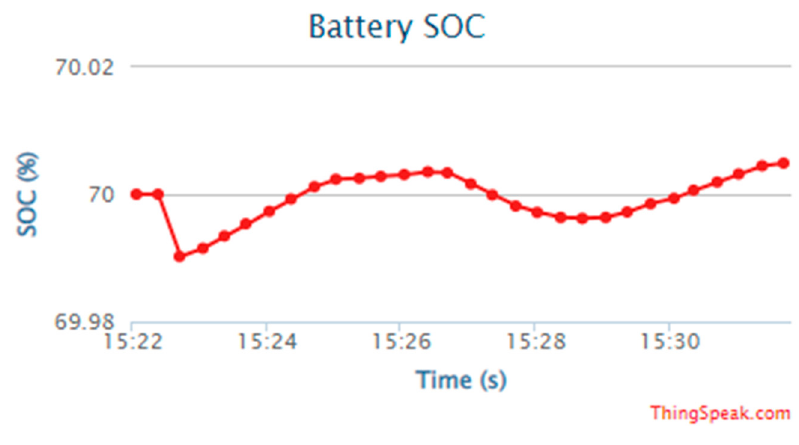
Figure 14. Variation in SOC (%).